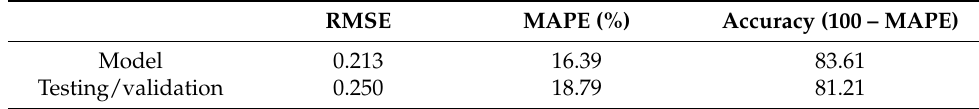
Table 1. Summary of model accuracy and validation results.